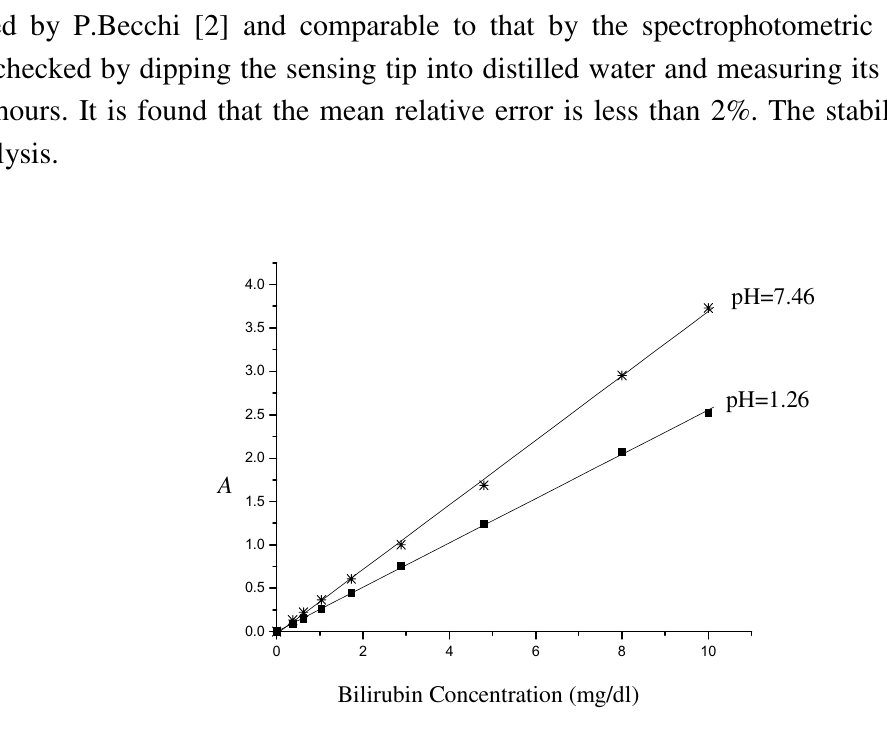
Figure 3. Absorbance A vs. concentration of the bilirubin standard